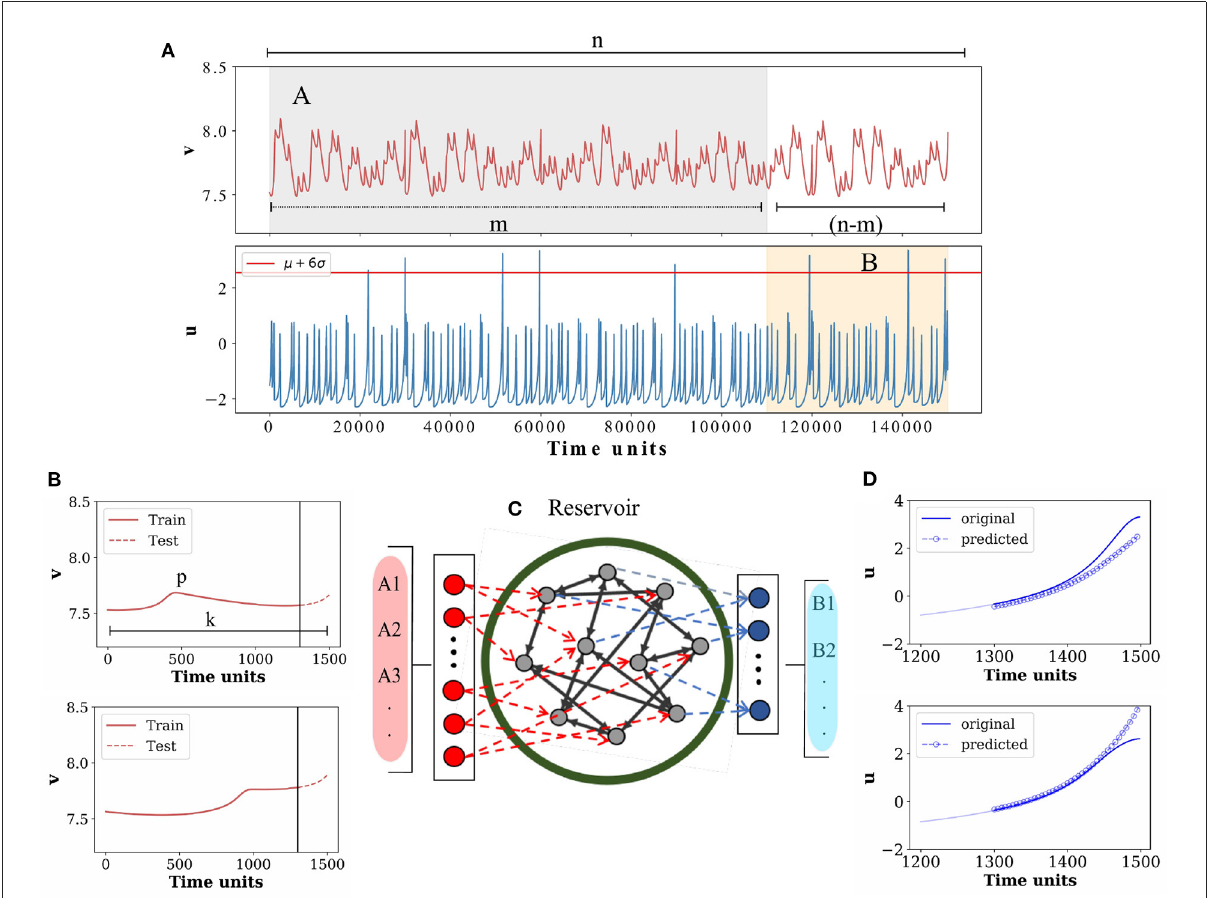
FIGURE2 Schematic diagram of the ESN and the prediction process. (A) Time series of the passive variable v (upper panel) and active variable u (lower panel) with a number of extreme events, here selected using a threshold height H s = µ + 6 σ , are shown. Data points ( k = 1,500) from v , and u prior to n extreme peaks are saved. A few exemplary extreme peaks are shown for demonstration. For our proposed scheme, data points around such n = 200 extreme peaks are collected. (B) Two exemplary input signals corresponding to two extreme events are shown here, while the actual number of input signals are m = 180 as for the training purpose. For each input node, p = 1,300 data points (solid red line) are used for training purpose and the rest of ( k − p ) = 200 data points (dotted red line) are used for testing, which are separated by a vertical line (black line). (C) Echo state network structure: input layer consists of A m nodes, where m = 180 input signals (data segments prior to each of the extreme events) are used for training. The output layer consists of B n − m = 20 nodes. (D) Preceding pattern of predicted u signals from 20 nodes each for ( k − p ) = 200 datapoints (blue circles) and the original u signal (blue line) for 200 datapoints are plotted for comparison. Two such output signals are shown as